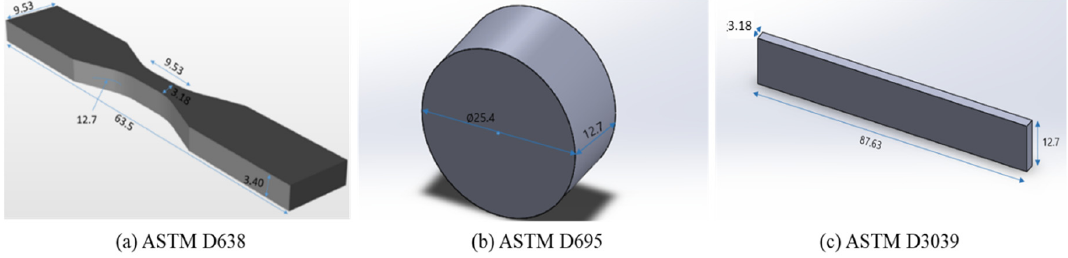
Figure 1. Sample designs and their dimensional information used for the experiments (unit: mm). ( a ) ASTM D638; ( b ) ASTM D695; ( c ) ASTM D3039.